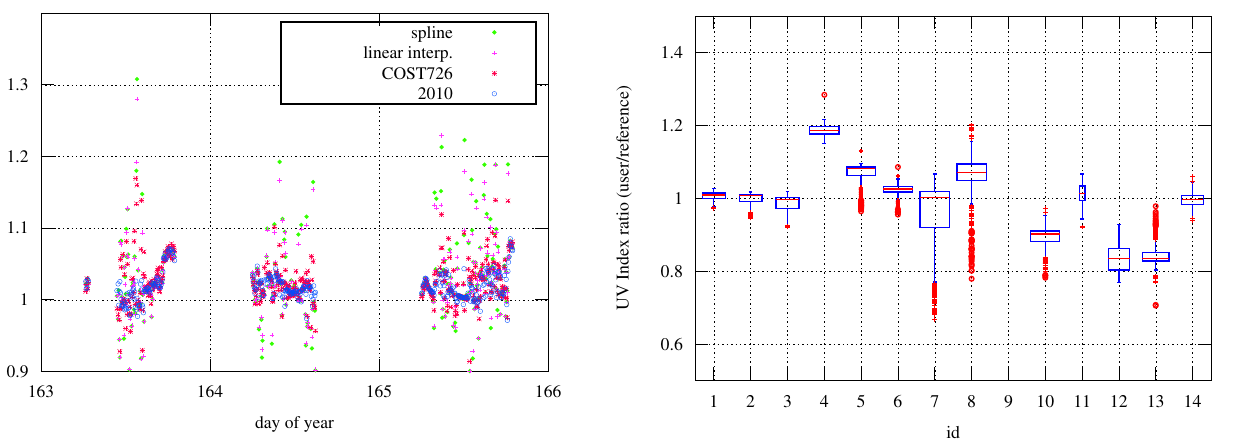
Fig. 5. Boxplot of UV Index ratios between each instrument and the reference, calculated under clear sky conditions. The top and the bottom of the boxes represent respectively the upper and the lower quartiles. The line inside every box depicts the median. The whiskers show minimum and maximum values except the outliers, which are drawn as cross (between 1.5 and 3 times the IQR) and circles (beyond 3 times the IQR). Instrument id 09 does not measure the UV